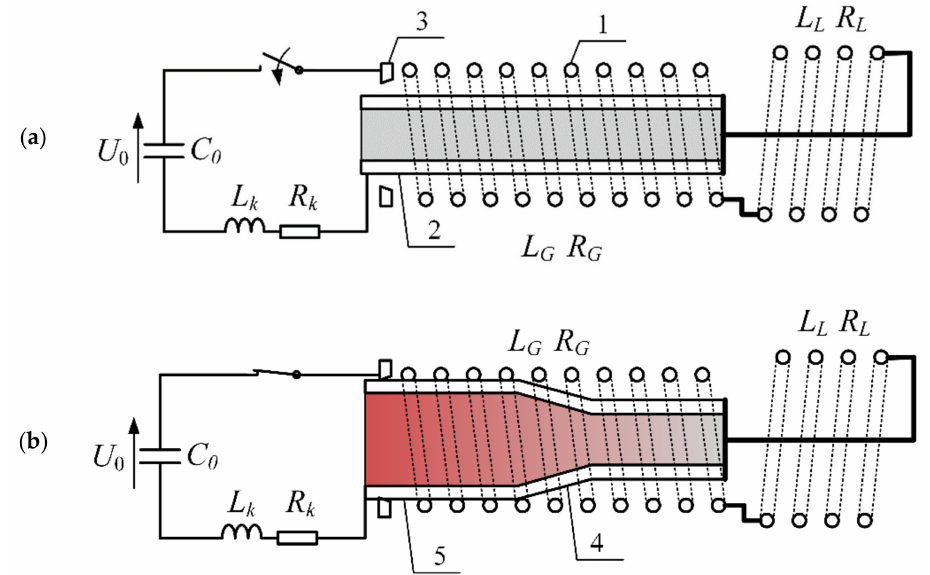
Figure 2. Schematic diagram visualizing the operating principle of FCG before detonation ( a ), and during the generation process ( b ): 1—FCG winding, 2—conductive armature filled with explosive material, 3—crowbar, 4—armature shorting wave front, 5—expanded part of the armature; C 0 — capacitor bank charged to the initial voltage U 0 , L k , R k —inductance and resistance of connections, L G , R G —inductance and resistance of the generator winding, L L , R L —inductance and resistance of the pulse forming